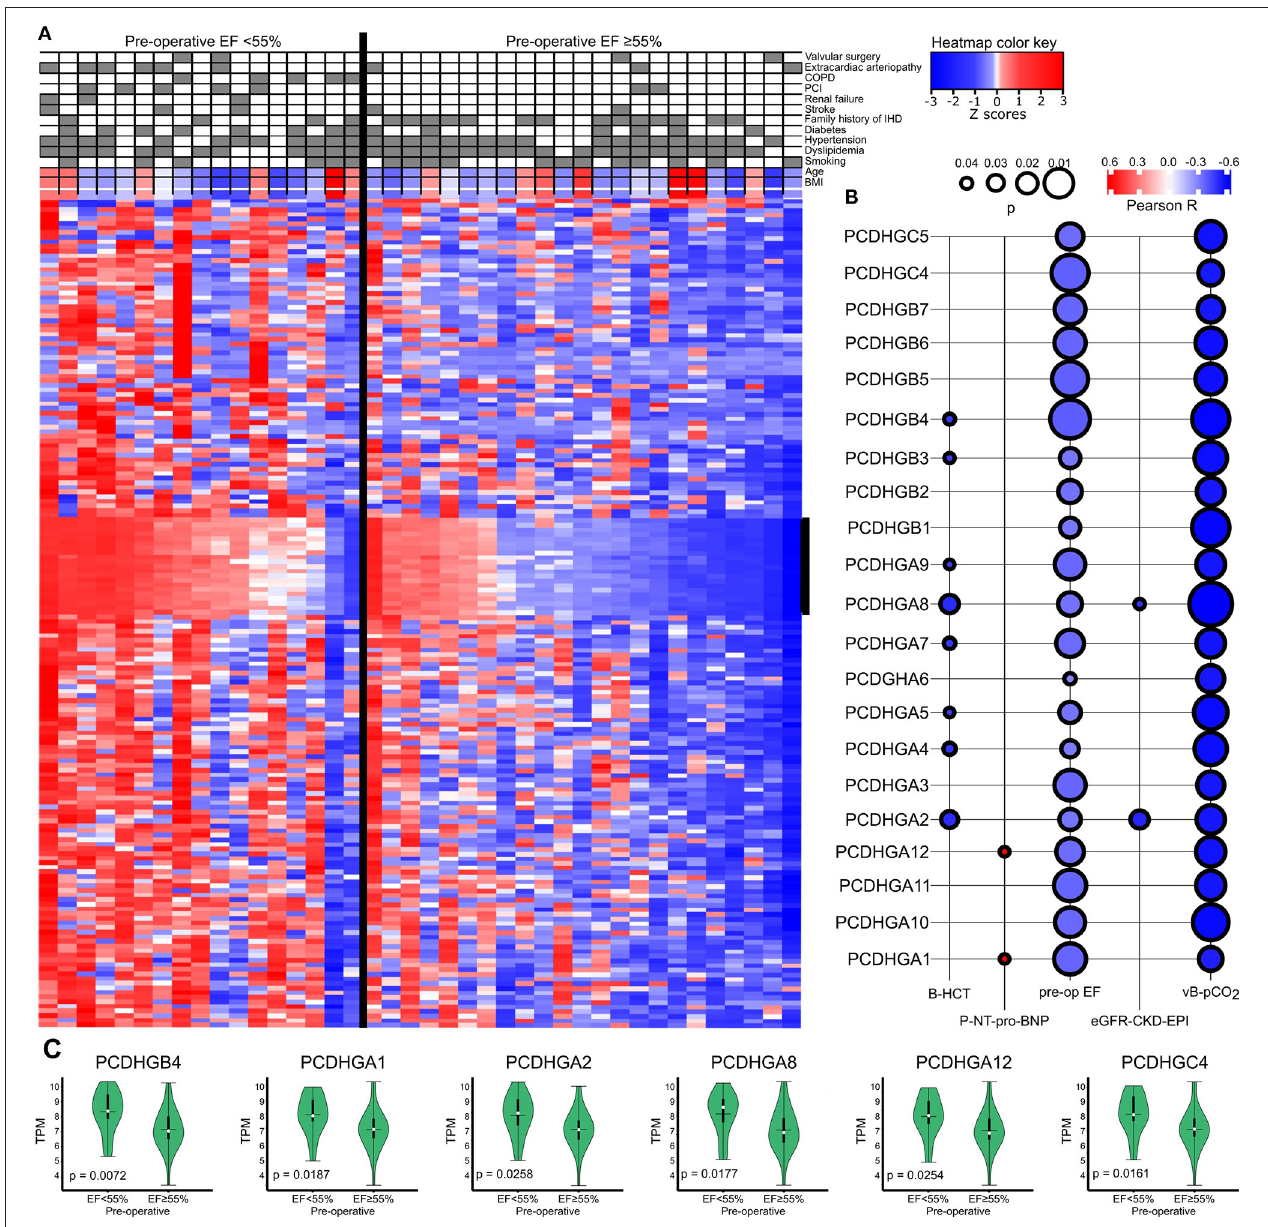
FIGURE 4 | (A) Heatmap showing a general overview of DEGs comparing the categorized EF groups in IHD patients. The heatmap color key expresses the Z-scores. (B) Correlations between PCDHGs and preoperative EF and preoperative laboratory values. The size of the bubble indicates the p -value and the color key indicates the Pearson R. (C) Correlations between preoperative EF and PCDHGs. EF, ejection fraction; PCDHG, protocadherin.